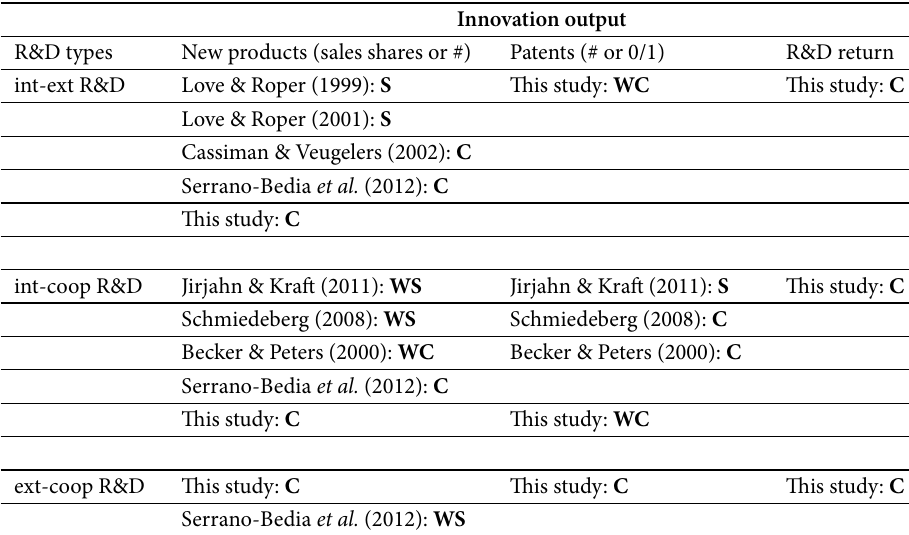
Table 6. Comparison of complementarity effects among different R&D strategies under different measures of innovation output